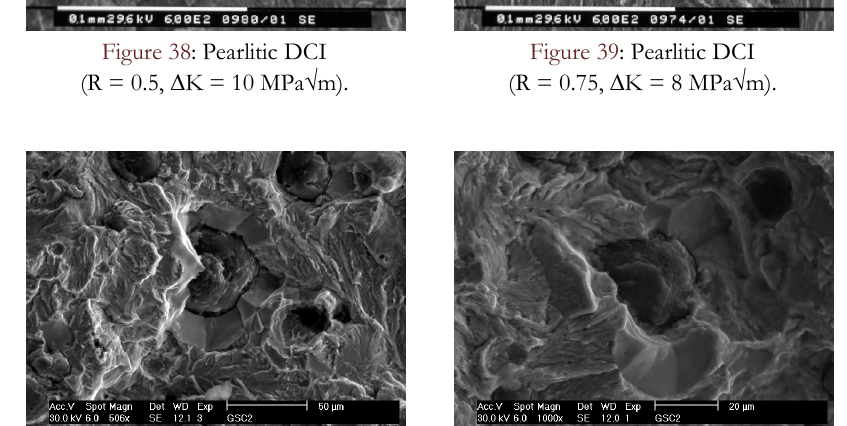
Figure 42: Ferritic-pearlitic DCI (R = 0.1,  K = 18 MPa √ m).